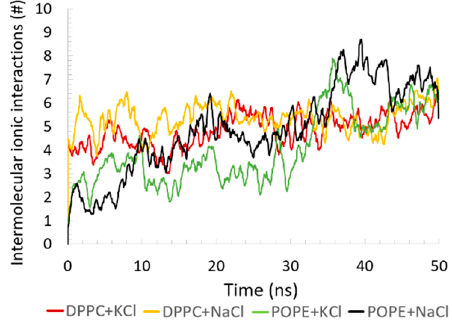
Figure 10. Intermolecular ionic interactions between the protein and the bilayers as a function of time.